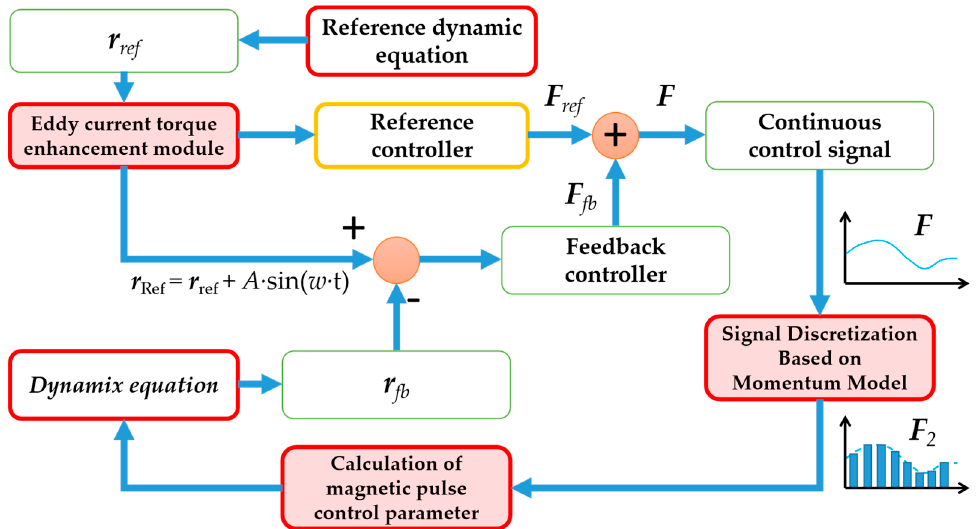
Figure 9. Magnetic pulse control loop.